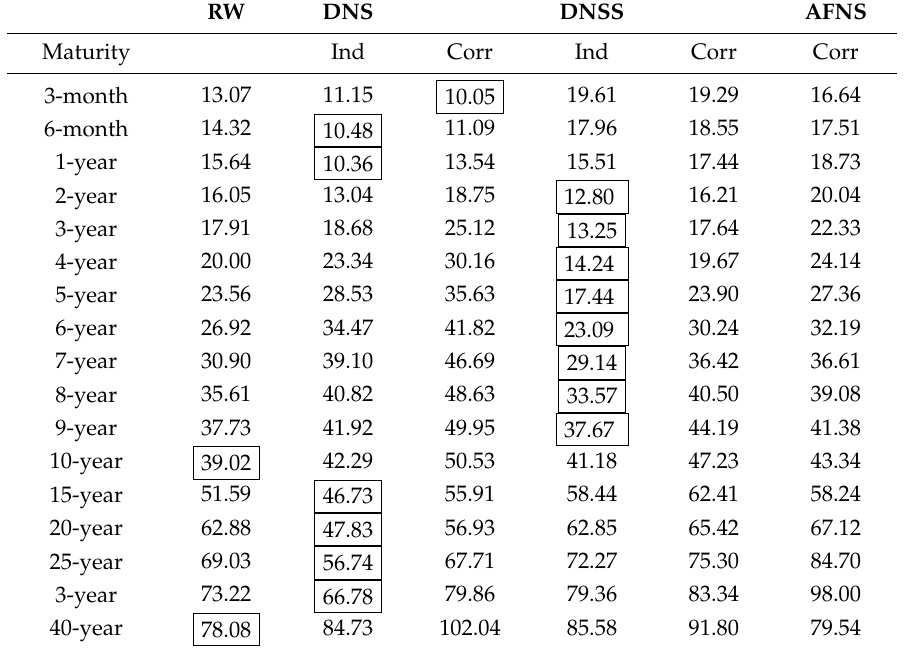
Table 7. Root mean squared forecast error of a 12-month